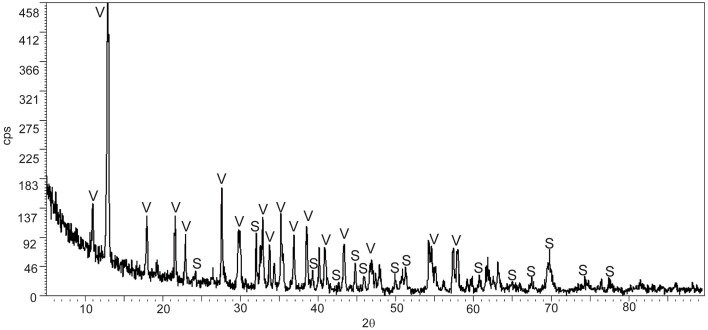
X-ray diffractogram of the bioprecipitates formed in T. Lapidicaptus anaerobic cultures. V, Vivianite; S, siderite.